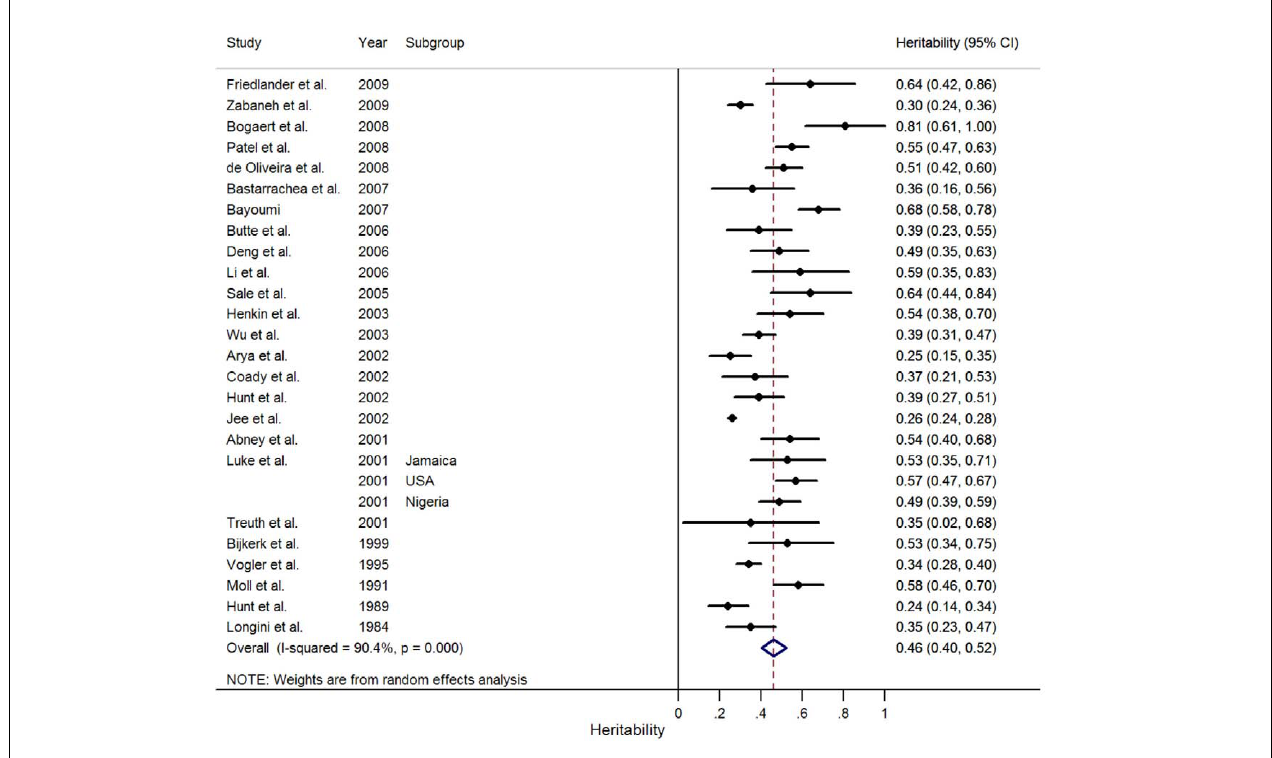
FIGURE 4 | Meta-analysis of BMI heritability estimates in family studies. The forest plot shows the results of a random effects meta-analysis of 27 independent BMI heritability estimates from 25 papers.